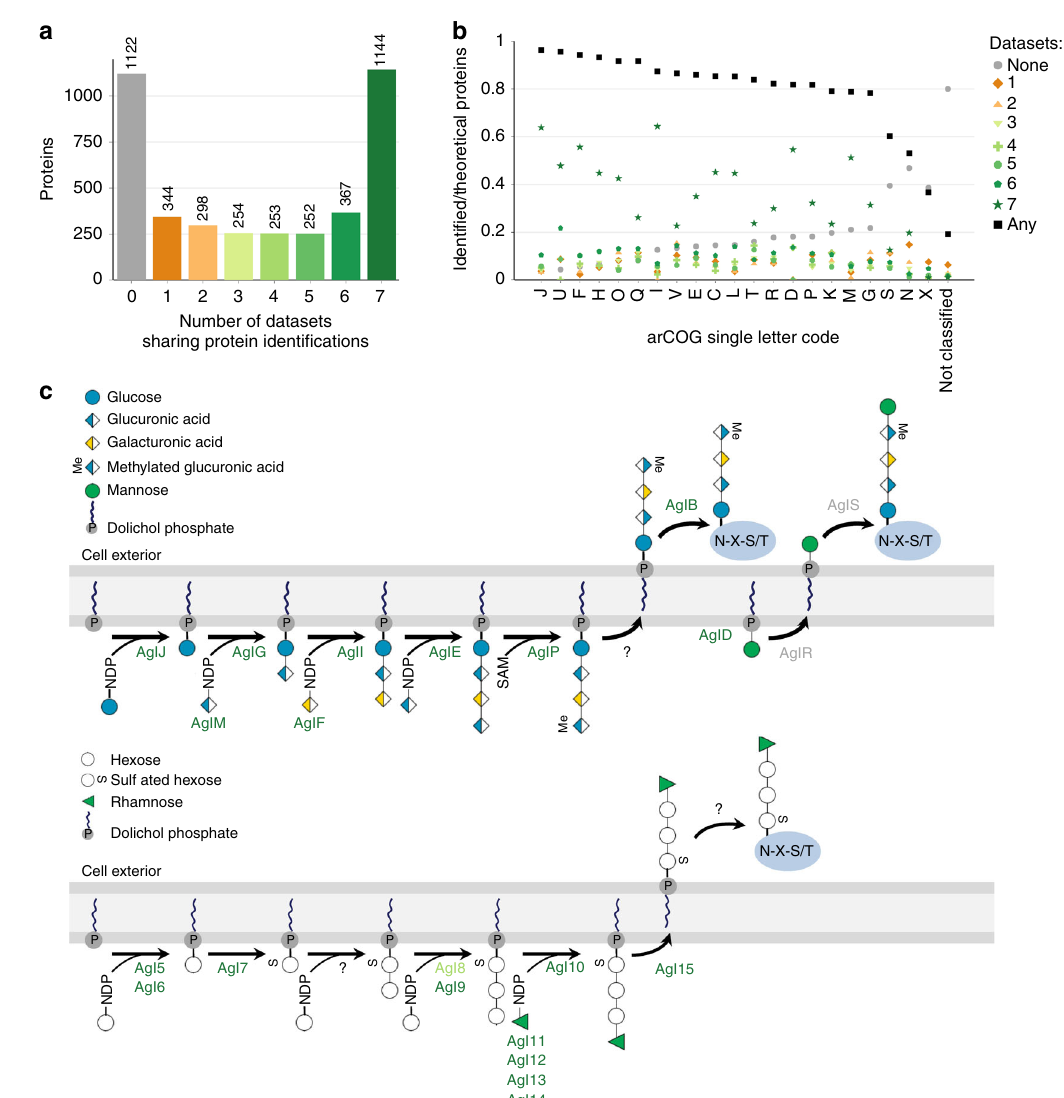
Fig. 4 Comparison of whole proteome datasets revealing ubiquitous presence of N -glycosylation pathway enzymes. a The overlap in protein identi fi cations between seven datasets that analyzed samples of whole proteomes has been determined. The number of proteins identi fi ed in the given number of datasets (1 – 7, green to orange, throughout this fi gure) is represented as a bar plot. For proteins that were not identi fi ed (0, gray), all ArcPP datasets were taken into account. b For each arCOG class (sorted by ArcPP identi fi cation rate), the identi fi cation rate for all proteins belonging to that class is given based on all proteins identi fi ed within the ArcPP (black), proteins not detected within the ArcPP, and proteins that are part of 1 – 7 whole proteome datasets. ArCOG classes are as follows: J, translation, ribosomal structure and biogenesis; U, intracellular traf fi cking, secretion, and vesicular transport; F, nucleotide transport and metabolism; H, coenzyme transport and metabolism; O, post-translational modi fi cation, protein turnover, chaperones; Q, secondary metabolites biosynthesis, transport and catabolism; I, lipid transport and metabolism; V, defense mechanisms; E, amino acid transport and metabolism; C, energy production and conversion; L, replication, recombination and repair; T, signal transduction mechanisms; R, general function prediction only; D, cell cycle control, cell division, chromosome partitioning; P, inorganic ion transport and metabolism; K, transcription; M, cell wall/ membrane/envelope biogenesis; G, carbohydrate transport and metabolism; S, function unknown; N, cell motility; X, mobilome. c The known steps of the two described N -glycosylation pathways in H. volcanii (top and bottom, AglB- and Agl15-dependent, respectively, based on refs. 58,74,113 ) are schematically shown with their corresponding enzymes colored according to the number of datasets in which they have been identi fi ed. Interestingly, while almost all known enzymes were identi fi ed in at least six datasets, AglR and AglS were not identi fi ed in these datasets at all. Notably, these are involved in the addition of the fi nal mannose to the AglB-dependent glycan and N -glycopeptides with and without the fi nal mannose attached have been readily identi fi ed previously 86,114 . Source data are provided as a Source data fi